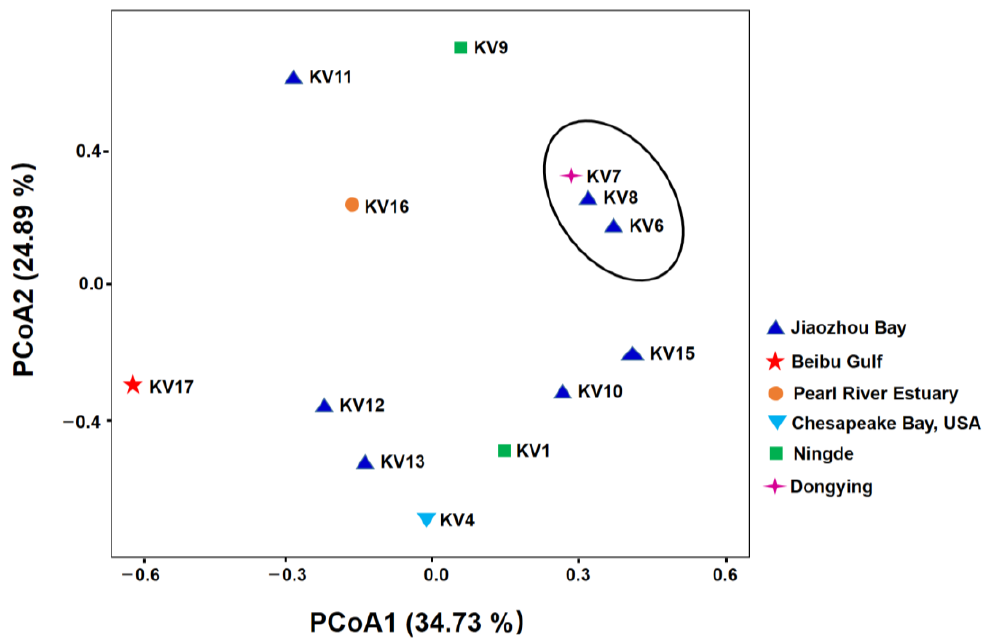
Figure 3. Principal coordinate analysis (PCoA) of fungal communities based on weighted UniFrac distances. The colors of the symbols indicate the original isolation sources of the